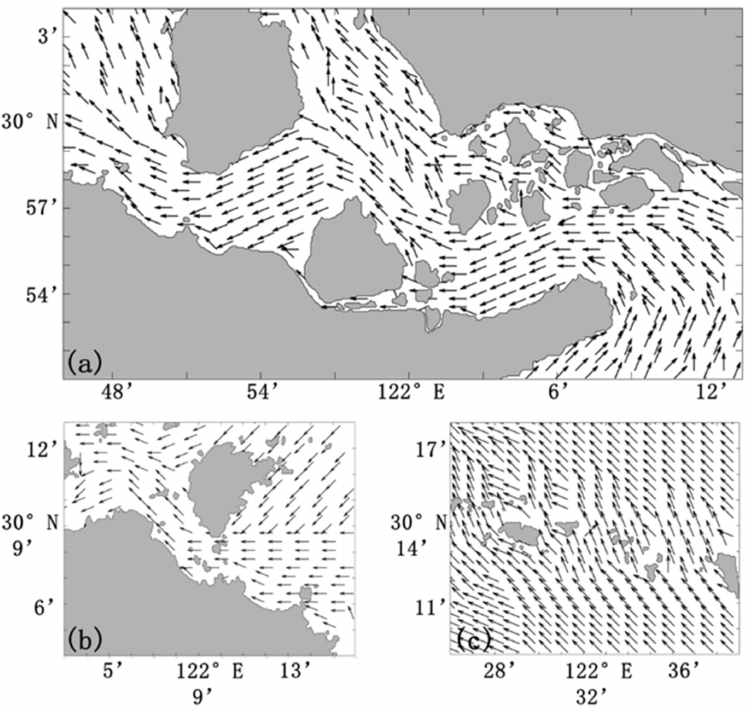
Figure 6. The MFD in ( a ) the Luotou Channel, ( b ) the Guanmen Channel, and ( c ) the Dongji Islands. Furthermore, the tidal currents at maximum flood and maximum ebb in the study areas are shown in Figure 7. The tidal currents in the Luotou Channel are stronger than those outside the channel, and the currents in the middle of the channel are stronger